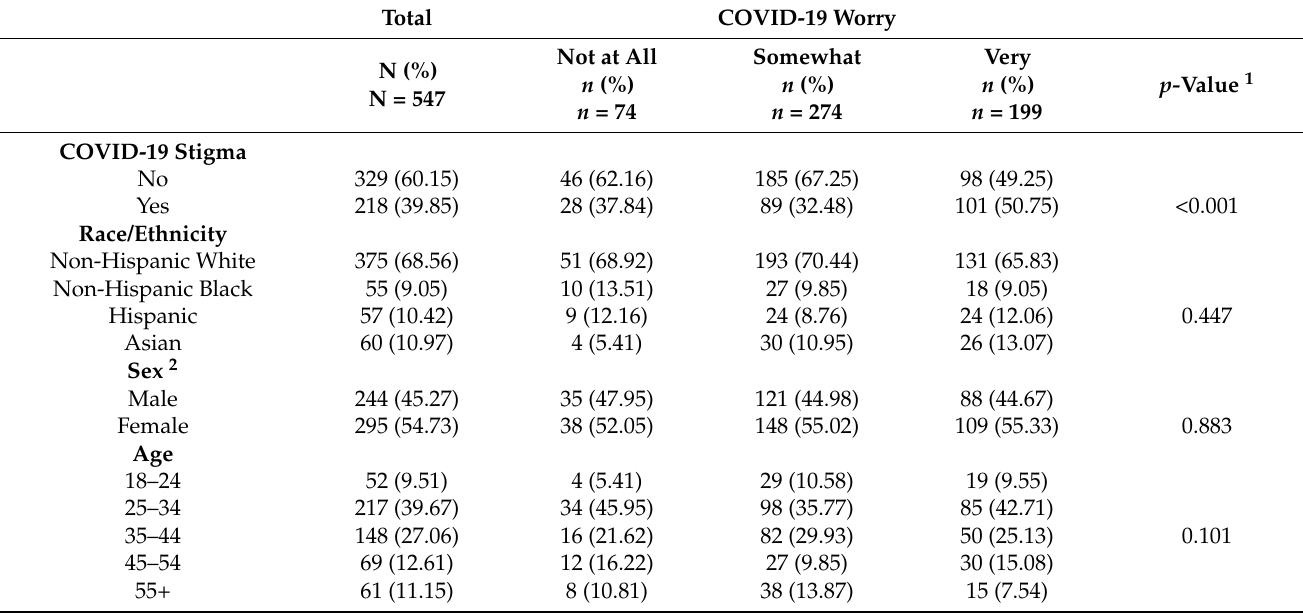
Table 1. Associations between MTurk worker characteristics and COVID-19 worry, New York State, N = 547.